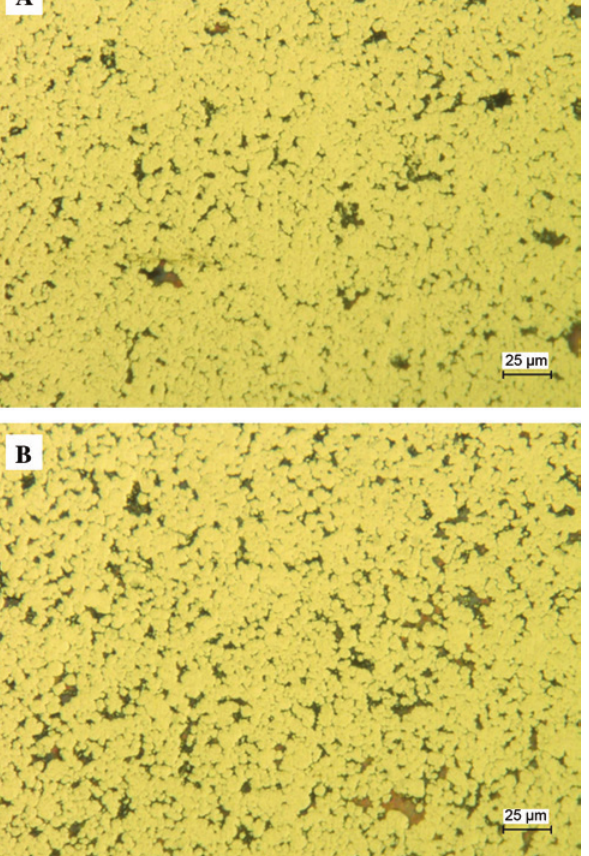
Figure 1: Microstructure of the base metals: (A) W75-Cu alloy; (B) W55-Cu alloy.